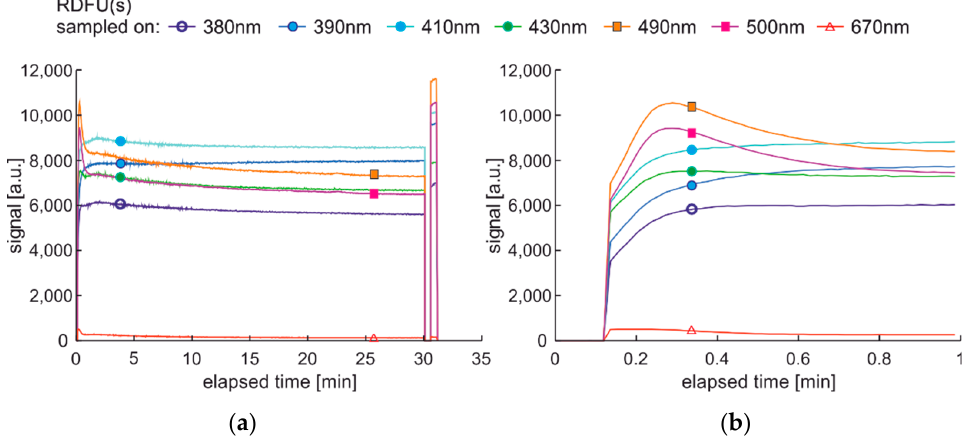
Figure 19. Set of time series of fluorescence data of regular diesel fuel RDFU(s) in cycle DCE:UVonTon: ( a ) full-time series; ( b ) zoom of the initial stage.